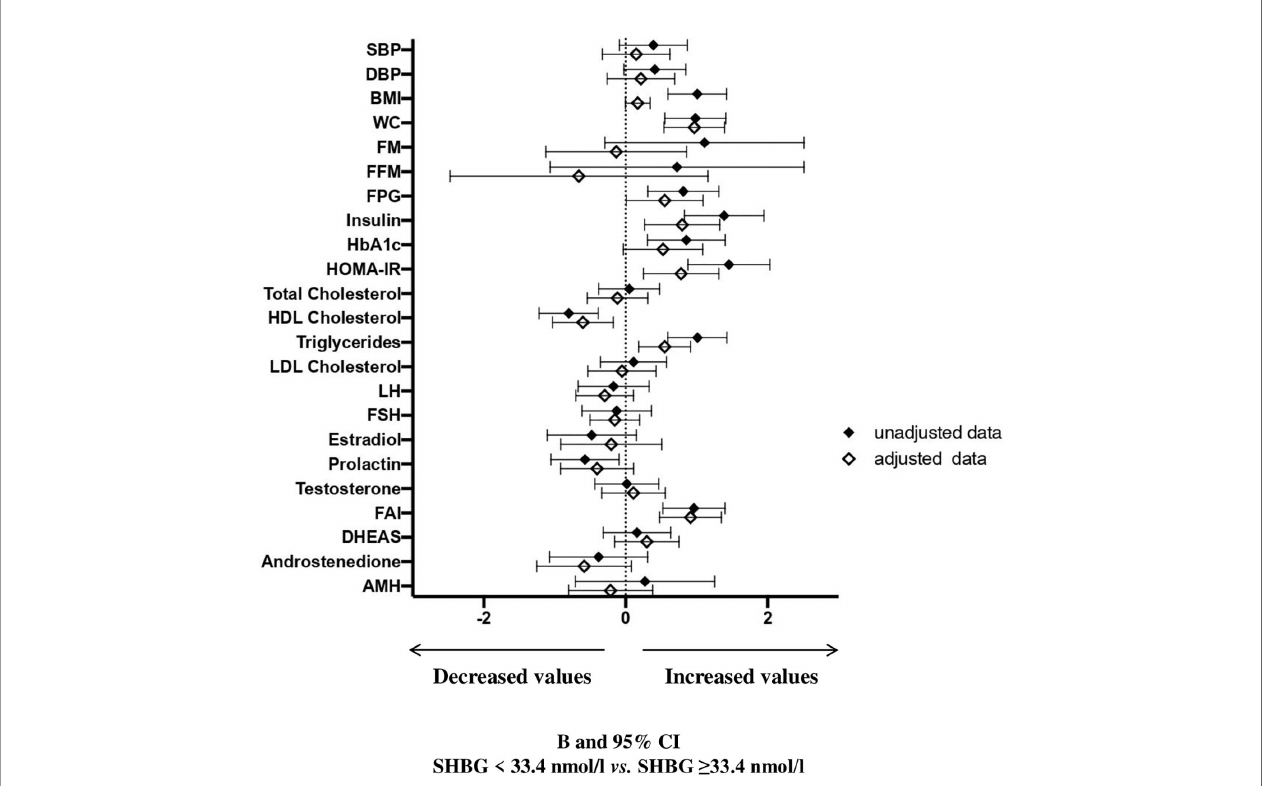
FIGURE 3 | B and 95% con fi dence interval (CI) for several metabolic and hormonal parameters as a function of SHBG <33.4 nmol/L as compared with SHBG ≥ 33.4 nmol/L in Cohort 2. Data are expressed as number of standard deviations from the mean value. The standardized values are based on log-transformed parameters. The statistics based on raw data are reported in Supplementary Table 2 . Black diamonds: unadjusted data; white diamonds: data adjusted for age and waist circumference. SBP, systolic blood pressure; DBP, diastolic blood pressure; BMI, body mass index; WC, waist circumference; FM, fat mass; FFM, free fat mass; FPG, fasting blood glucose; HbA1c, glycated hemoglobin; HOMA, Homeostatic Model Assessment for Insulin Resistance; HDL, High-Density Lipoprotein; LDL, low-density lipoprotein; LH, Luteinizing hormone; FSH, Follicle-stimulating hormone; FAI, Free androgen index; DHEAS, Dehydroepiandrosterone sulfate; AMH, Anti-müllerian hormone; V,